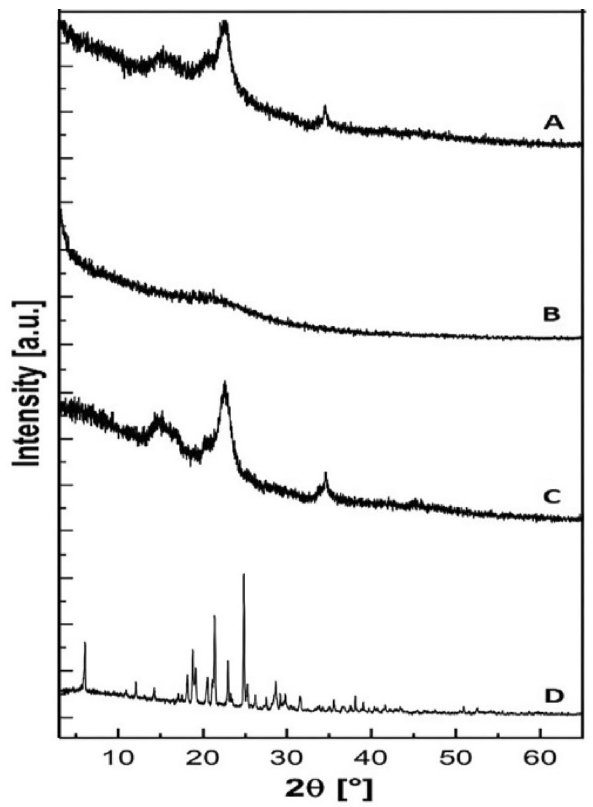
Figure 5. XRD patterns of (A) LS powder, (B) Aerosil 200, (C) Avicel PH101, (D)